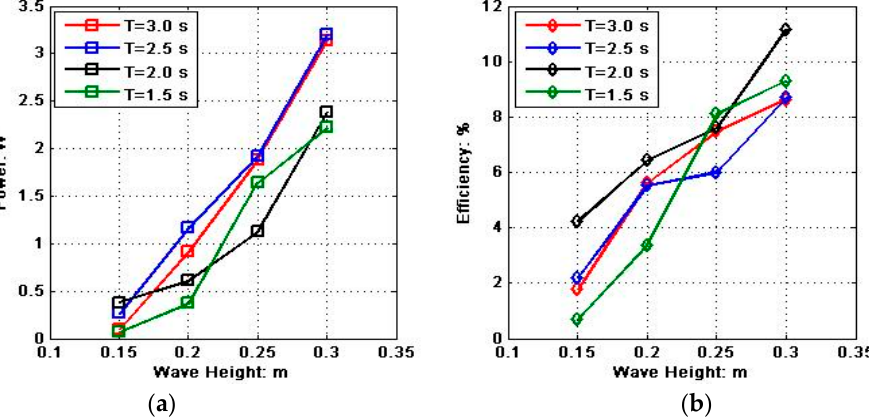
Figure 15. Generation performance of the ACWEC with different wave heights, M 1 = 14.21 kg: ( a ) power curve; ( b ) efficiency curve.